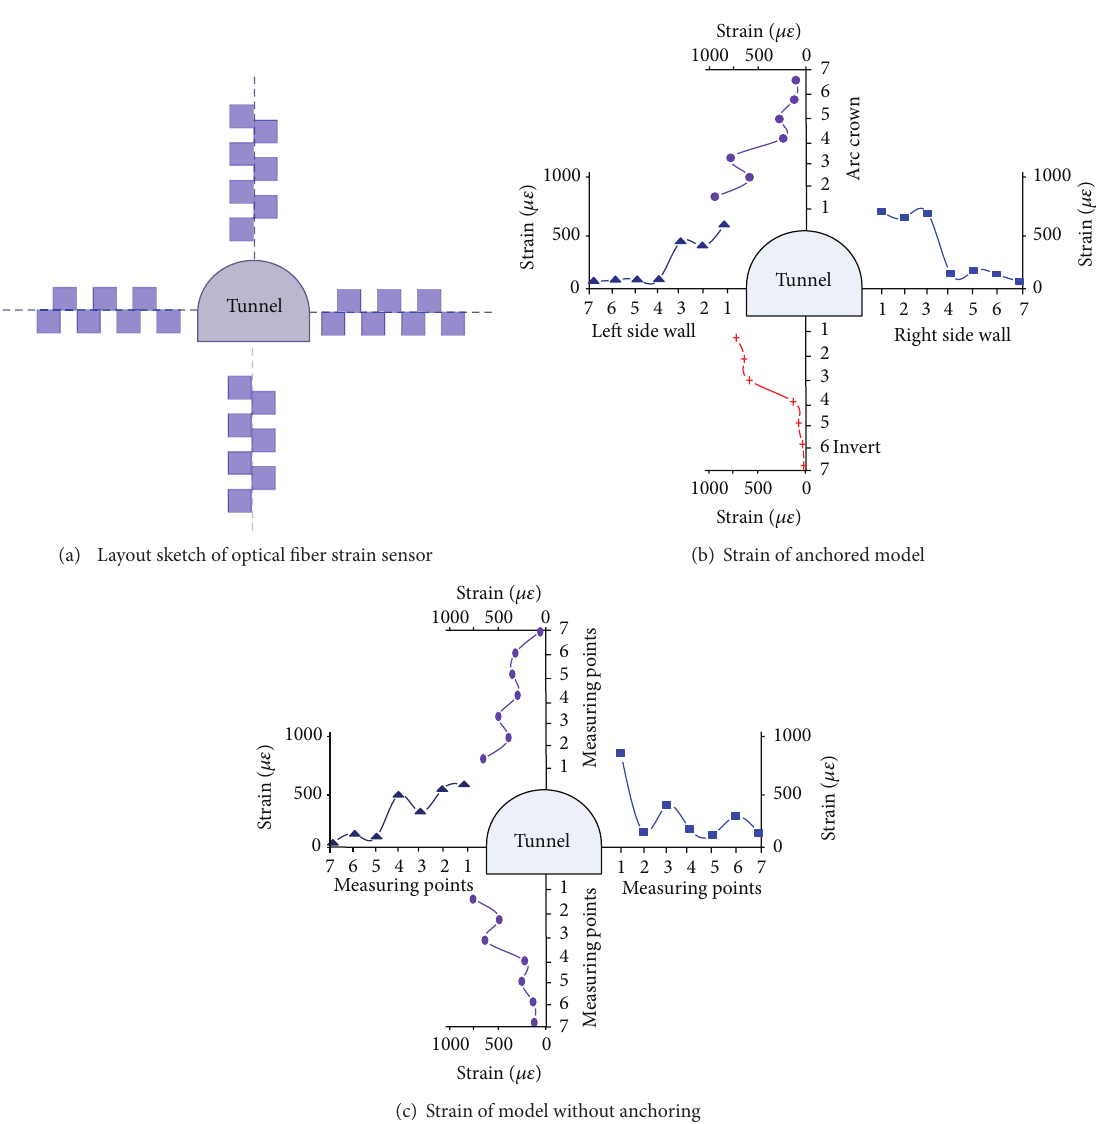
Figure 16: Radial strain around tunnel measured by optical fiber strain